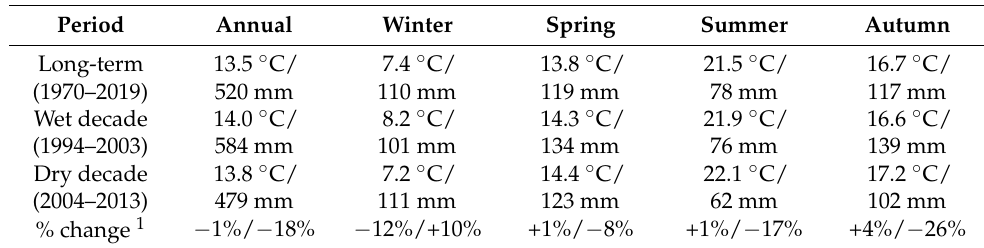
Table 1. Annual and seasonal values of mean temperature and precipitation during the long-term reference period (1970–2019) and the two decades considered in this study: wet (1994–2003) and